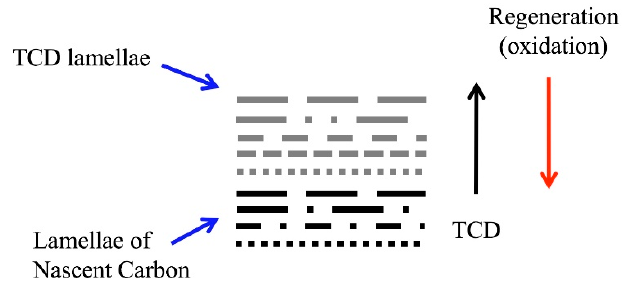
Figure 5. Illustration of deposited carbon strata (gray lines) upon the initial catalyst (solid black lines). The regeneration course through the strata is illustrated by the downward red arrow—the length of which represents the regeneration depth through the deposited carbon; it is dependent upon regeneration temperature and time, whereas TCD is denoted by the black arrow. Initial deposition may mimic/replicate the catalyst nanostructure initially, but with continued deposition the nanostructure of the deposit evolves. Regeneration, as a separate process, removes deposited carbon “layers,” with deeper levels of regeneration exposing ever earlier stages of carbon deposition and corresponding nanostructure. HRTEM is ideally suited for differentiating between the nascent carbon catalyst and carbon deposit throughout these cycles.